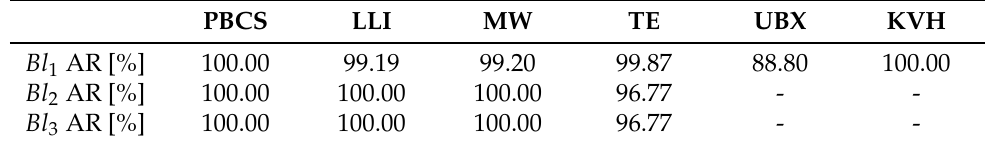
Table 2. Ambiguity resolution success ratios of the different solutions—Case Study 1.